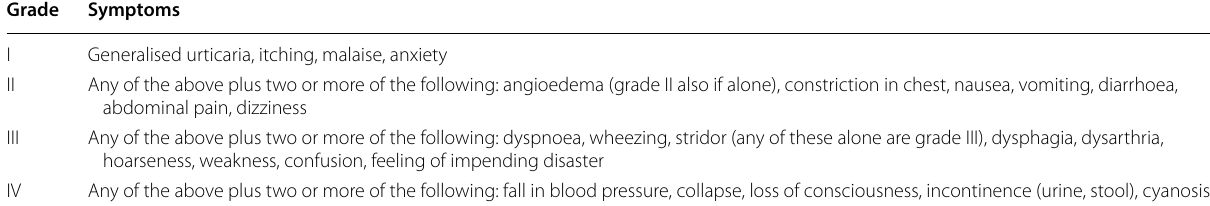
Table 1 Classification of systemic sting reactions (after H. L. Mueller [16], modified by U. R. Mueller